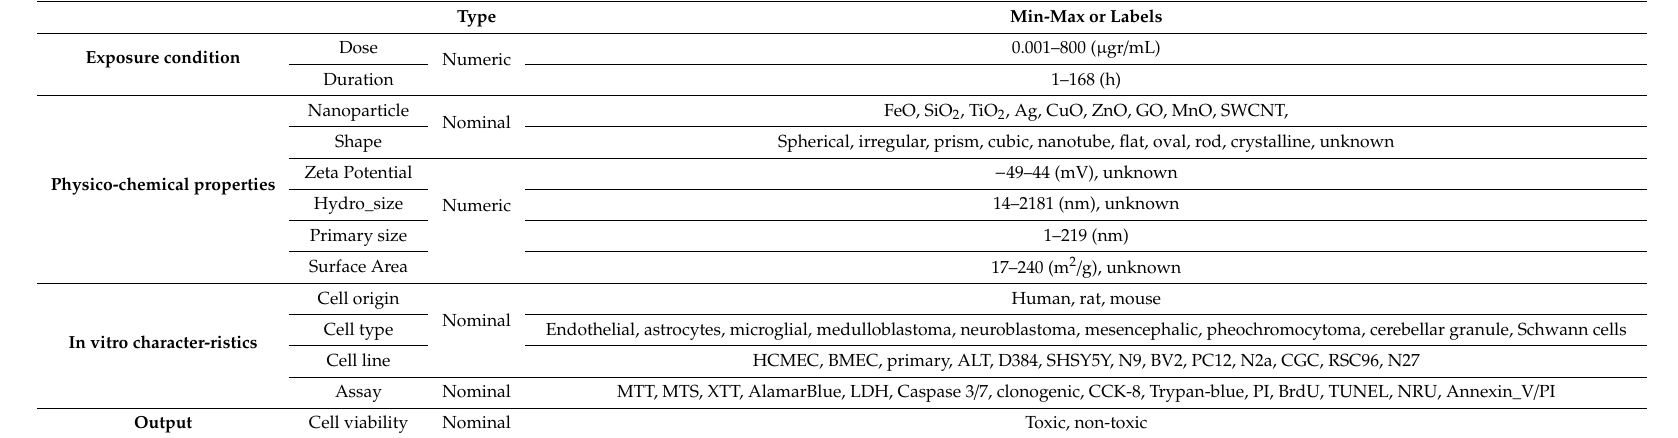
Table 2. Input final variables, type of input and information related to the labels and